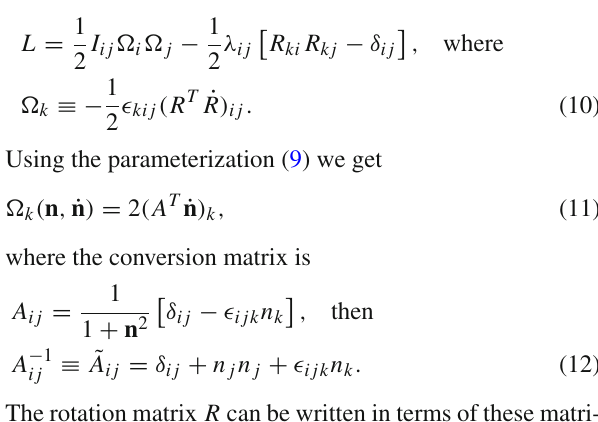
only some 9 − 6 = 3 independent parameters to specify the matrix R